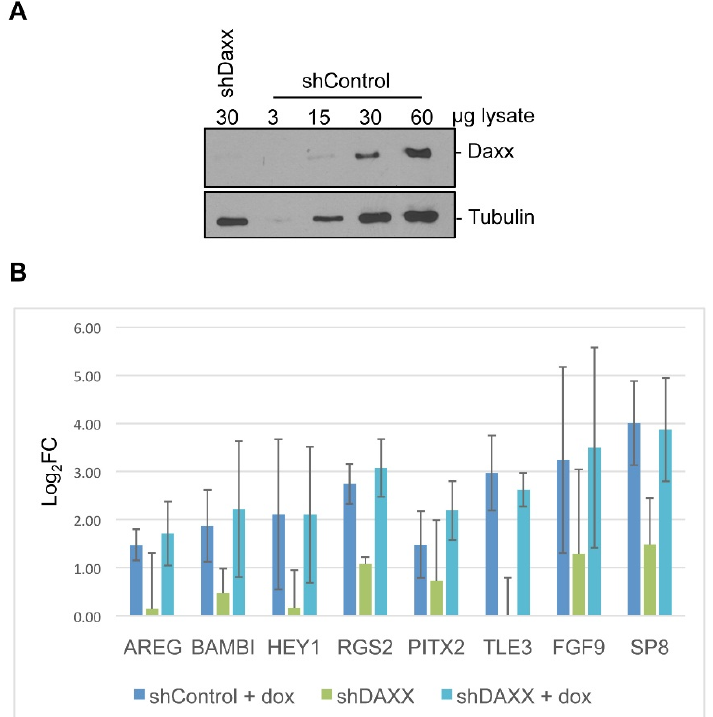
Figure 5. Loss of Daxx does not impede the up-regulation of E4-ORF3 target genes. ( A ) Pools of Tet-E4-ORF3 cells were stably infected with retrovirus that express short hairpin RNA directed against Daxx or a nonspecific control. 60, 30, 15, and 3 μ g of shControl lysate were loaded on a polyacrylamide gel with 30 μ g of shDaxx and subject to Western blot analysis; ( B ) shDaxx and shControl cells were mock-treated or supplemented with dox to express E4-ORF3 for 24 hours. Transcript levels were recorded by relative quantification RT-qPCR. Bars represent log 2 fold change in expression in mock treated shDaxx cells, dox-induced shDaxx cells, or dox-induced shControl cells, relative to mock-treated shControl cells, normalized to GAPDH. Error bars = S.D., n = 3. No statistically significant difference in transcript levels could be detected between dox-induced control cells and dox-induced shDaxx cells as determined by one-way ANOVA analysis with multiple